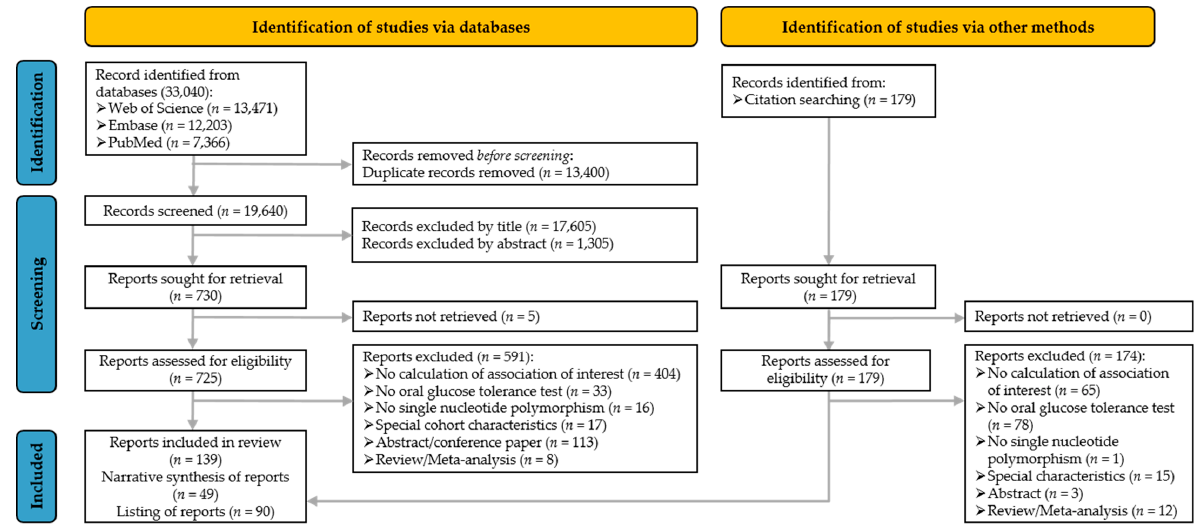
Figure 1. Flow chart of the systematic literature search according to [8].